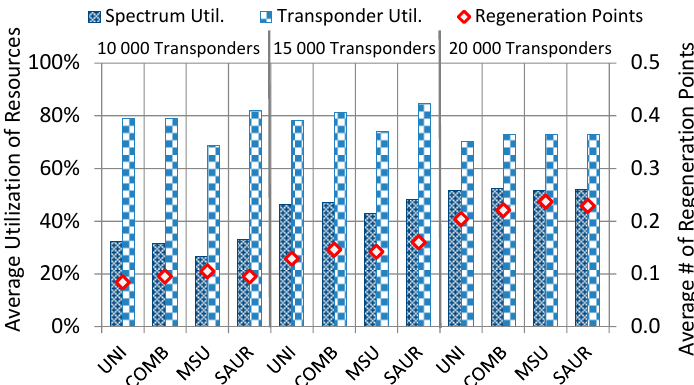
Figure 13. Utilization of spectrum and transponders and average number of regeneration points for the US26 network and TP C as a function of various algorithms and number of transponders.